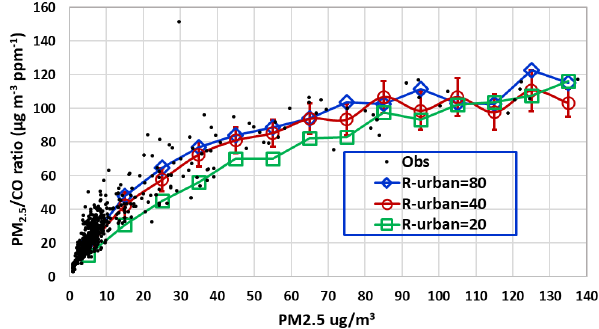
Figure 4. PM 2 . 5 / CO ratio (µgm − 3 ppm − 1 ) vs. PM 2 . 5 . The black dots show the observations, and the blue diamonds, red circles and green squares show the influence of the R urban parameter on the Monte Carlo simulations. The simulation results are binned in 10µgm − 3 intervals centered on the indicated values. For these sim- ulations, R smoke is fixed at 140. Error bars show 1 σ in the middle simulation. One observation is not shown (PM 2 . 5 / CO ratio of 122 and a PM 2 . 5 concentration of 159µgm − 3